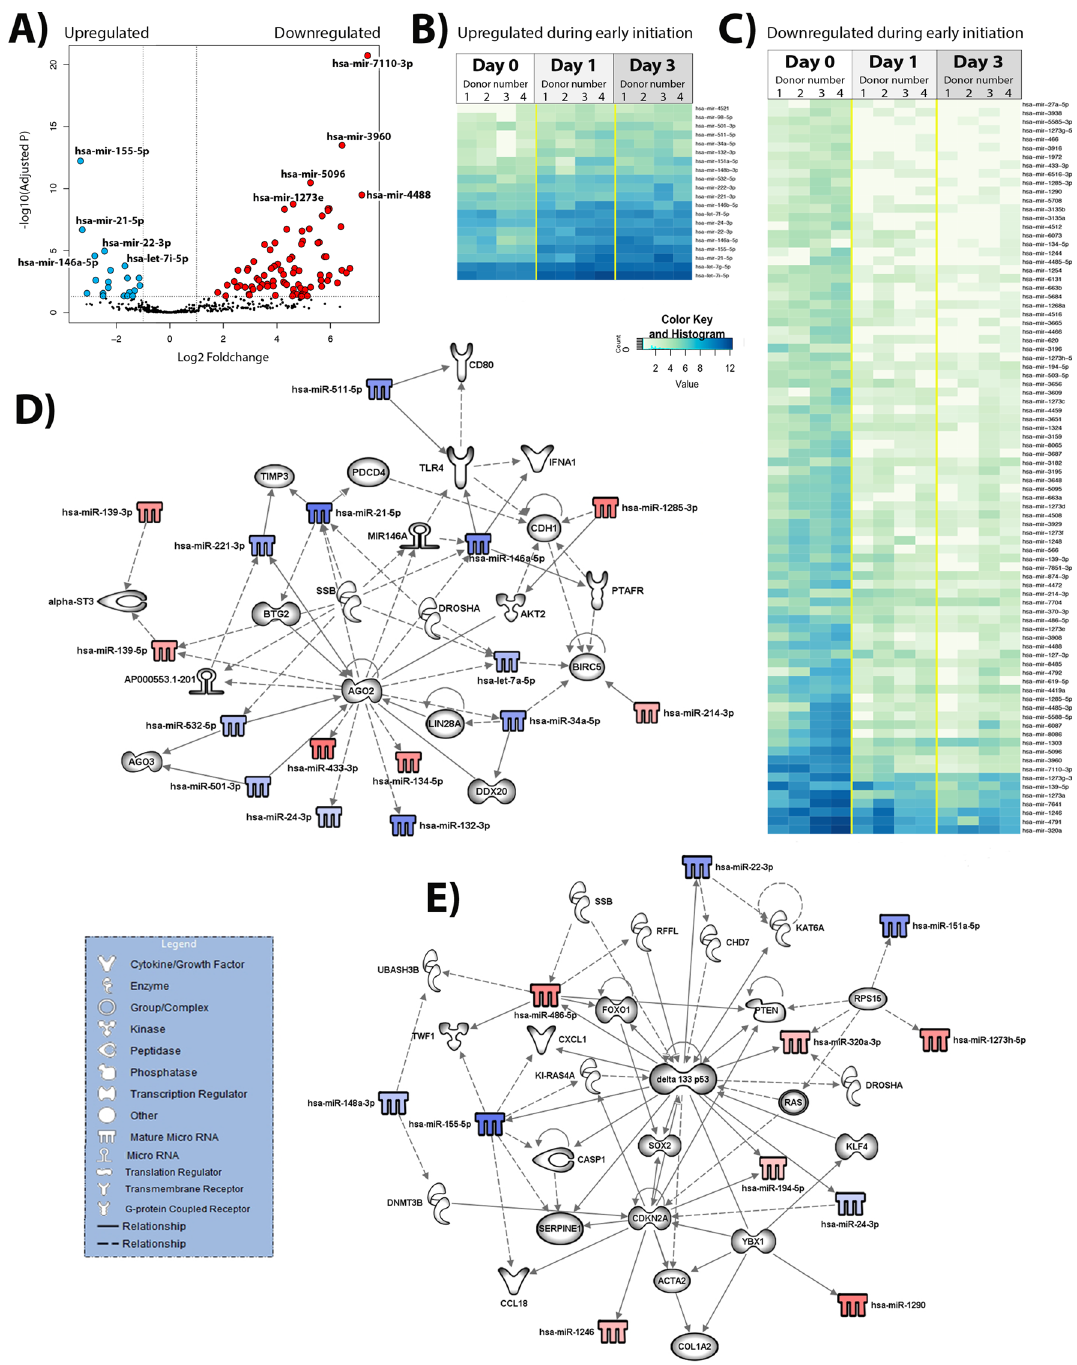
Figure 2. Differential expression of human HSC activation during the initiation stage. ( A ) Volcano plot of the comparison between the freshly isolated, quiescent HSC (day 0, n = 4) and day 3 HSC (initiation of activation, day 3, n = 4). In blue—differentially under-expressed miRNA in day 0; in red—differentially over-expressed miRNA in day 0 (p-adjusted < 0.05 and foldchange > 1). ( B ) Heatmap of the 20 significantly under-expressed miRNA in day 0 when compared to day 3, p-adjusted < 0.05. ( C ) Heatmap of the 84 significantly over-expressed miRNA in day 0 when compared to day 3, p-adjusted < 0.05. ( D ) and ( E ) Biological networks of differentially expressed miRNA. In blue and red, under and over-expressed miRNA, respectively. Shadowed in grey are molecules related to miRNA, as displayed on the legend. Lines represent different relationships between the molecules and